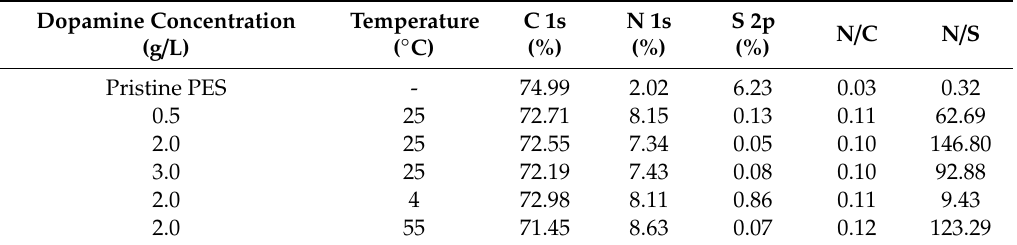
Table 1. Surface compositions in atomic percentages of the pristine PES and PDA-coated PES